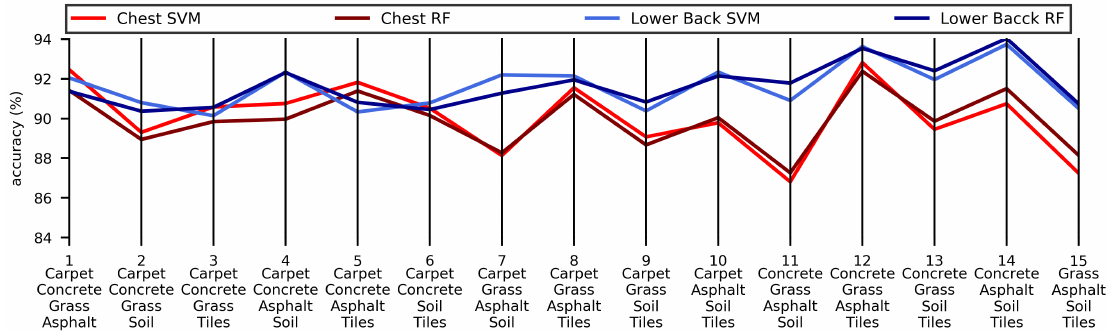
Figure A3. Parallel coordinate chart of quaternary classification . The results were obtained with all features set (194 features) for each classifier and for each sensor location.